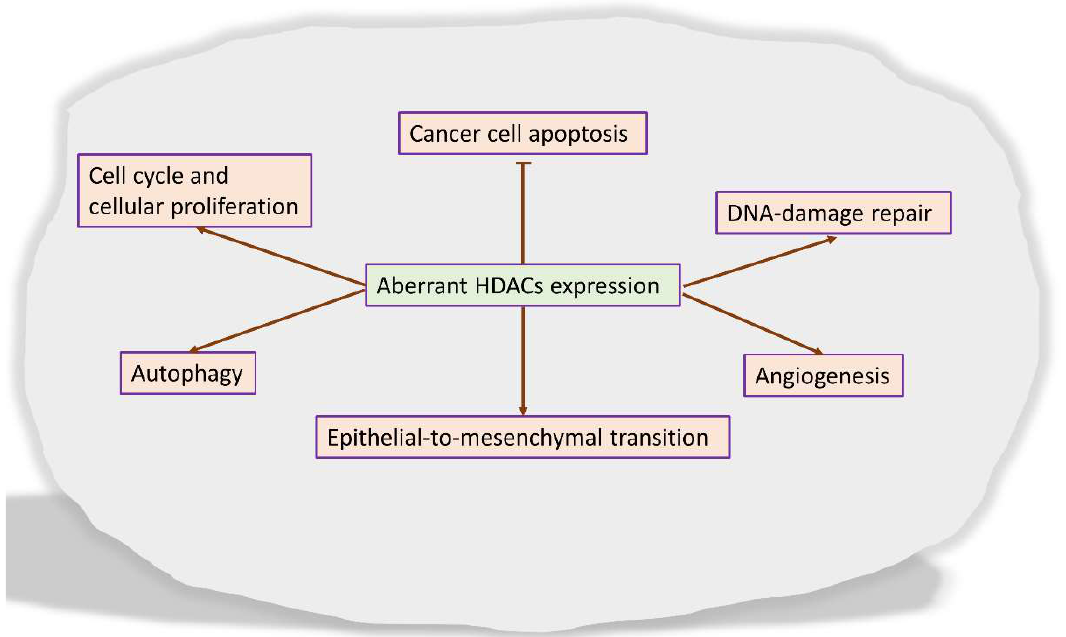
Figure 2. The hallmarks of histone deacetylases in cancer biology. HDACs enzymes mediate cancer cell malignancy by promoting cell proliferation, autophagy, DNA-damage repair, and tumor angiogenesis while inhibiting apoptosis. Furthermore, HDACs contribute to the expression of metastatic phenotypes by triggering the epithelial to the mesenchymal transition program. Arrows indicate stimulation, and the bar represents inhibition.